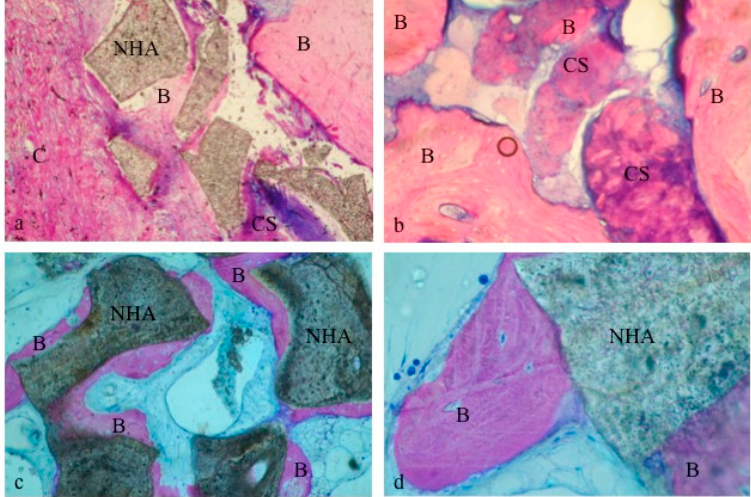
Figure 6. Biomaterial particles appeared to be surrounded by new bone: CS + NHA group ( a ); CS group ( b ); NHA group ( c , d ). B: bone; C: connective tissue; CS: Calcium Sulphate; NHA: sintered nanohydroxyapatite. Original magnification 40× (a,c) and 100× (b,d).